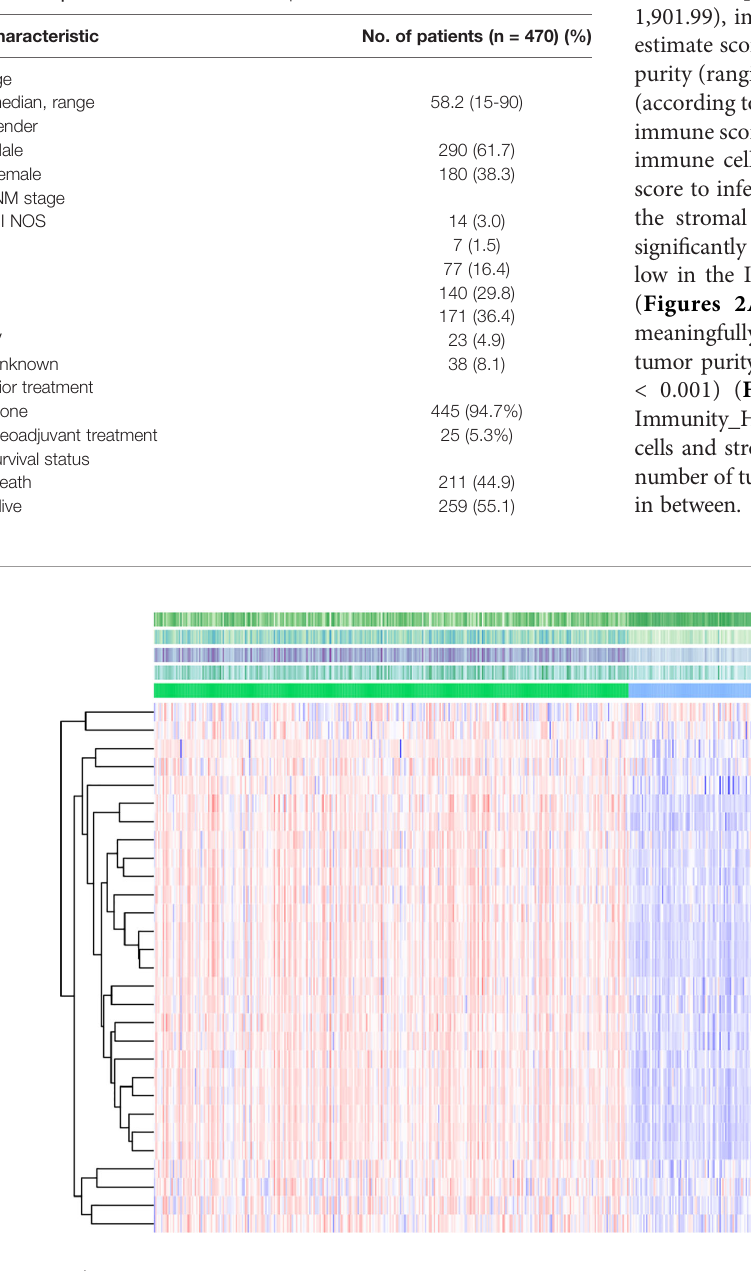
FIGURE 1 | Hierarchical clustering of Cutaneous melanoma into three subtypes. Hierarchical clustering of 470 tumors based on 29 immune-associated gene sets. Immunity_H, Immunity High; Immunity_M, Immunity Medium; Immunity_L, Immunity Low. Tumor purity, estimate scores, stromal scores, and immune scores were evaluated by ESTIMATE.